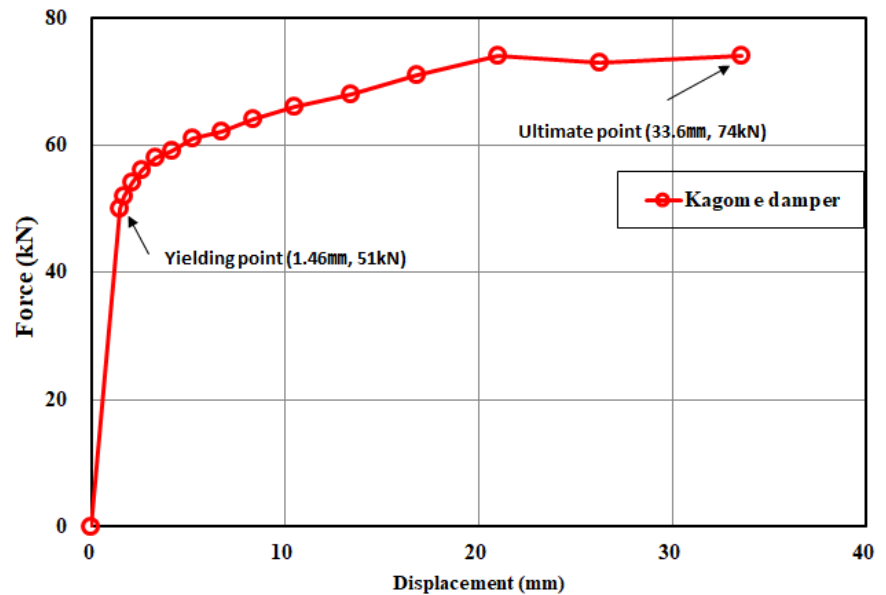
Figure 13. Load–displacement relationship. Figure 13. Load – displacement relationship.